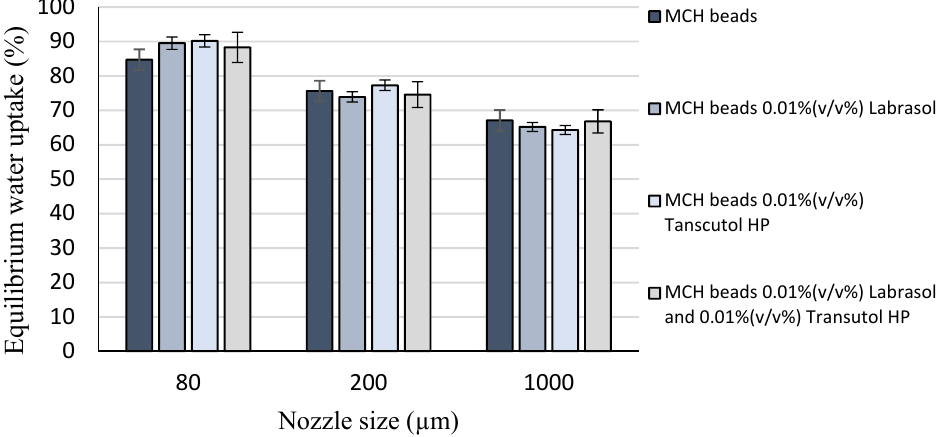
Figure 2. Bead swelling behavior according to the nozzle size applied for the formulation. Equilibrium water uptake is highly affected by particle size. Each data point represents the mean ± SD, n = 5.